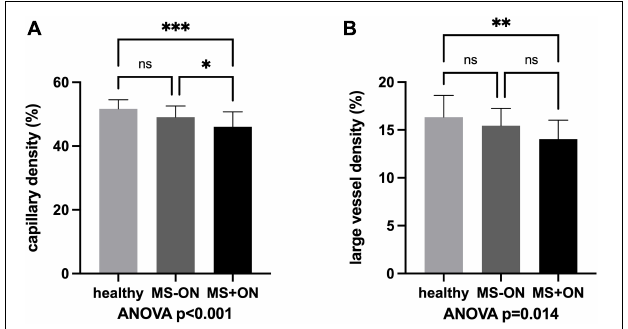
FIGURE 2 | Capillary density (A) and large vessel density (B) in eyes with history of acute optic neuritis (MS+ON), in contralateral eyes with no history of ON (MS-ON) and healthy control eyes are significantly different between the study groups upon ANOVA analysis. MS+ON eyes showed a significantly reduced capillary density as compared to MS-ON and healthy eyes while large vessel density was significantly different between healthy and MS+ON eyes, only. Data are presented as means ± standard deviation. ∗ p < 0.05, ∗∗ p < 0.01, ∗∗∗ p < 0.001, ns, not